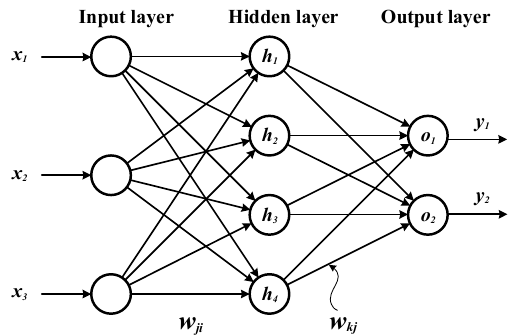
Figure 2. Architecture of our artificial neural network.